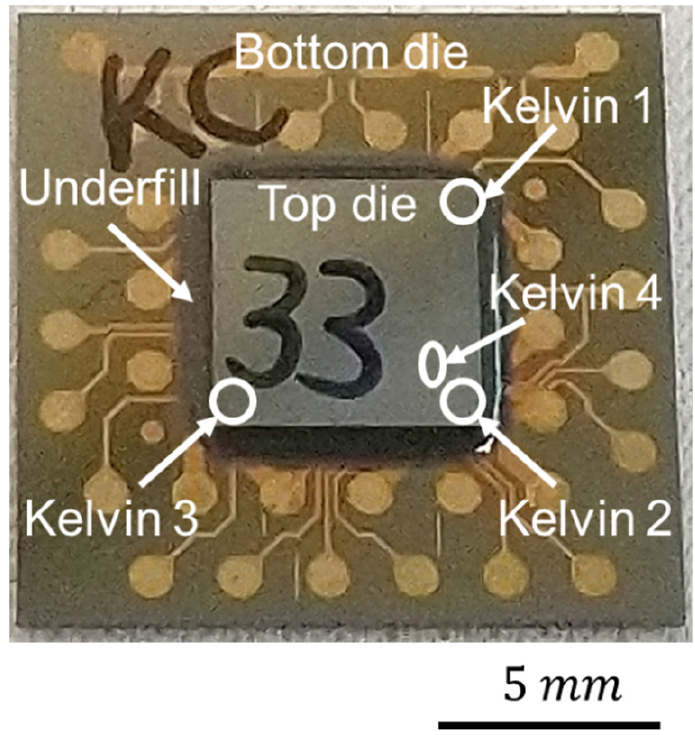
Figure 1. The test vehicle of Cu–Cu direct bonding and EM test. After the bonding process, underfill was dispensed into the chip. The sites of electrical test structures are marked on the chip.